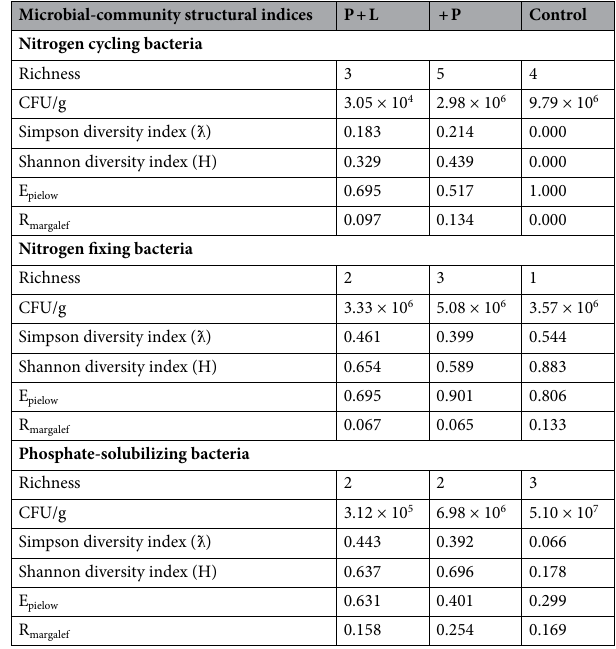
Table 2. The microbial community structural indices in soils supplemented with phosphorus and lime, soils rich in phosphorus and control soils collected at Ukulinga farm, KwaZulu-Natal.